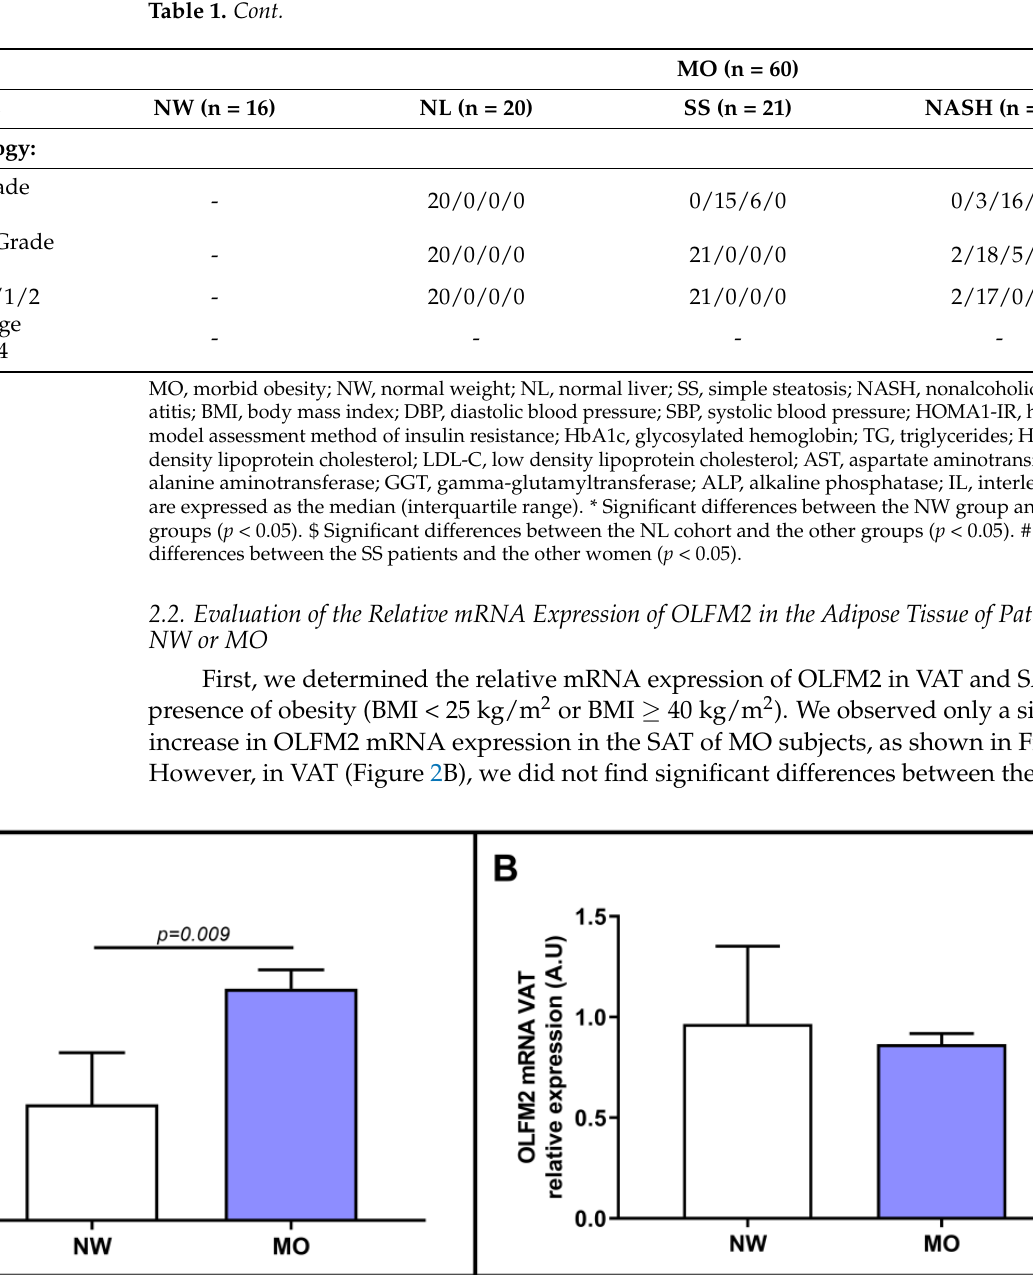
Figure 2. Comparison of mRNA abundance of OLFM2 in SAT ( A ) and in VAT ( B ) between patients with NW and MO. NW, normal weight; MO, morbid obesity; OLFM2, olfactomedin 2; VAT, visceral adipose tissue; SAT, subcutaneous adipose tissue; A.U, arbitrary units. Mann–Whitney test was used to calculate differences between groups, and p < 0.05 was considered statistically significant.